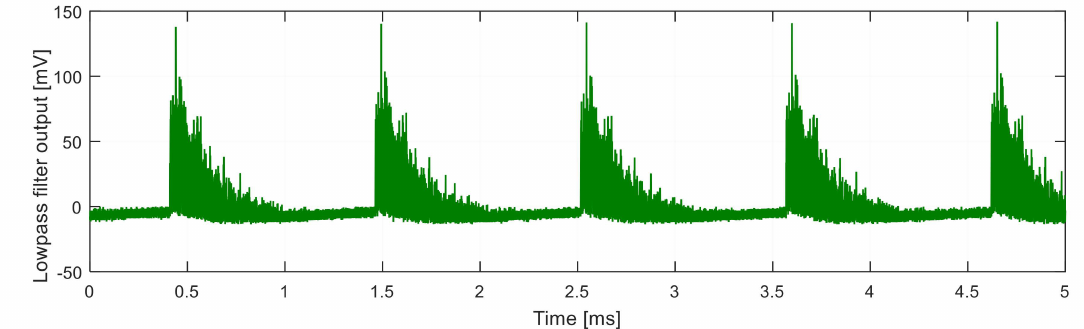
Figure 14. Signal after demodulation without equalization.